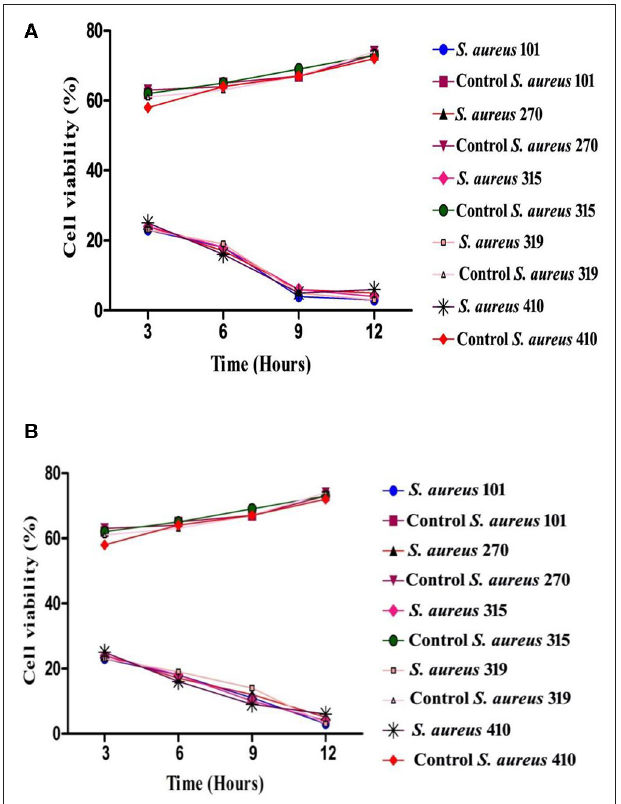
FIGURE 2 | (A) Time-kill kinetic assay of arborine compound on different MDR Staphylococcus aureus strains. (B) Time-kill kinetic assay of skimmianine compound on different MDR Staphylococcus aureus